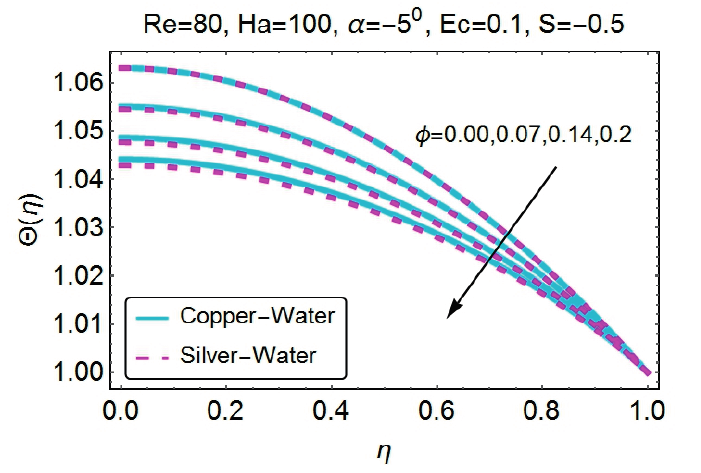
Figure 19. Change in temperature for varying ϕ (convergent channel/shrinking case).